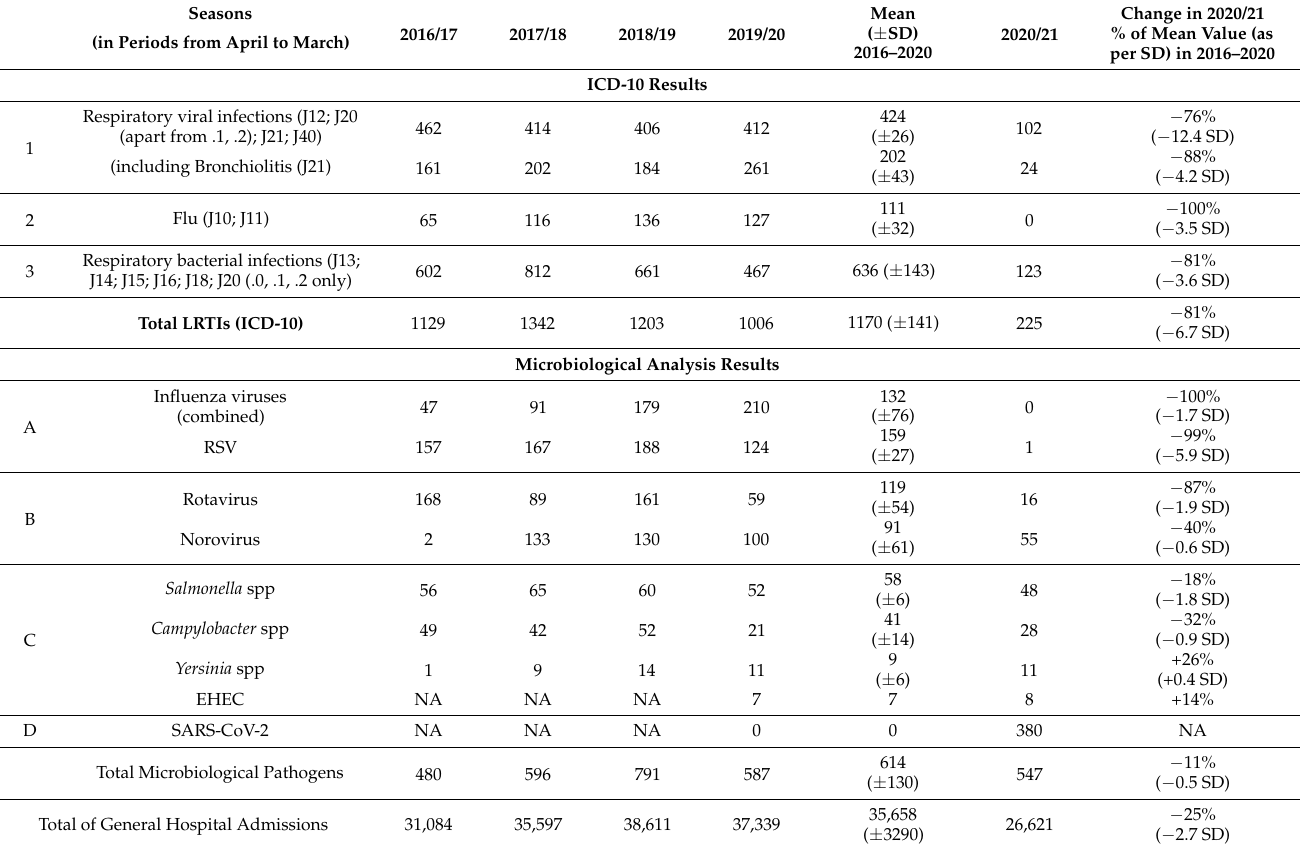
Table 1. Annual summary of infections during the 2016–2021 seasons at the Children’s Hospital of the Medical University of Warsaw. LTRIs—lower respiratory tract infections, SD—standard